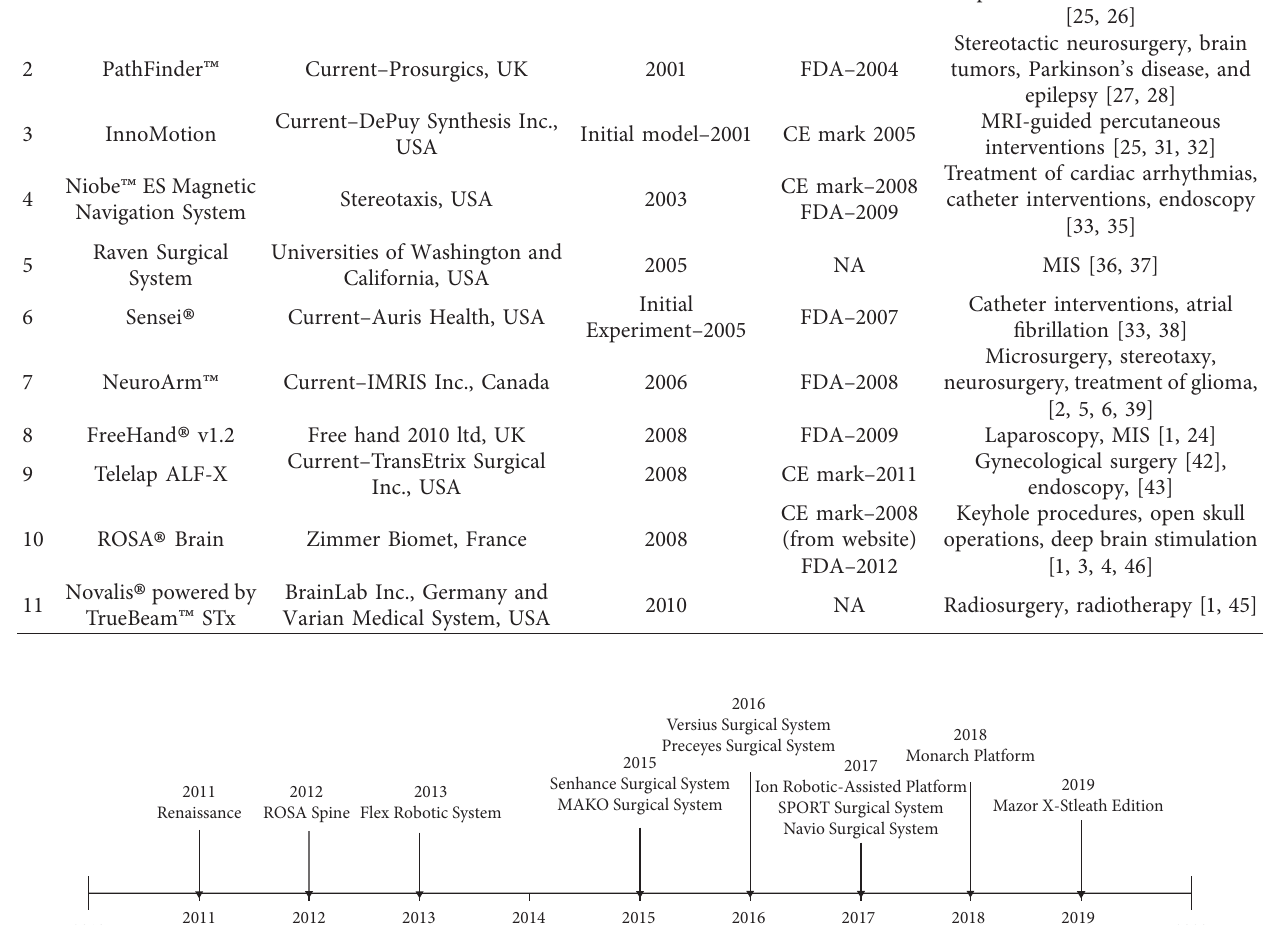
Figure 3: Decade III–timeline of robotic systems that show the recent advancement in the field of medical robots based on the advancement of technology and effort of three decades of research in this